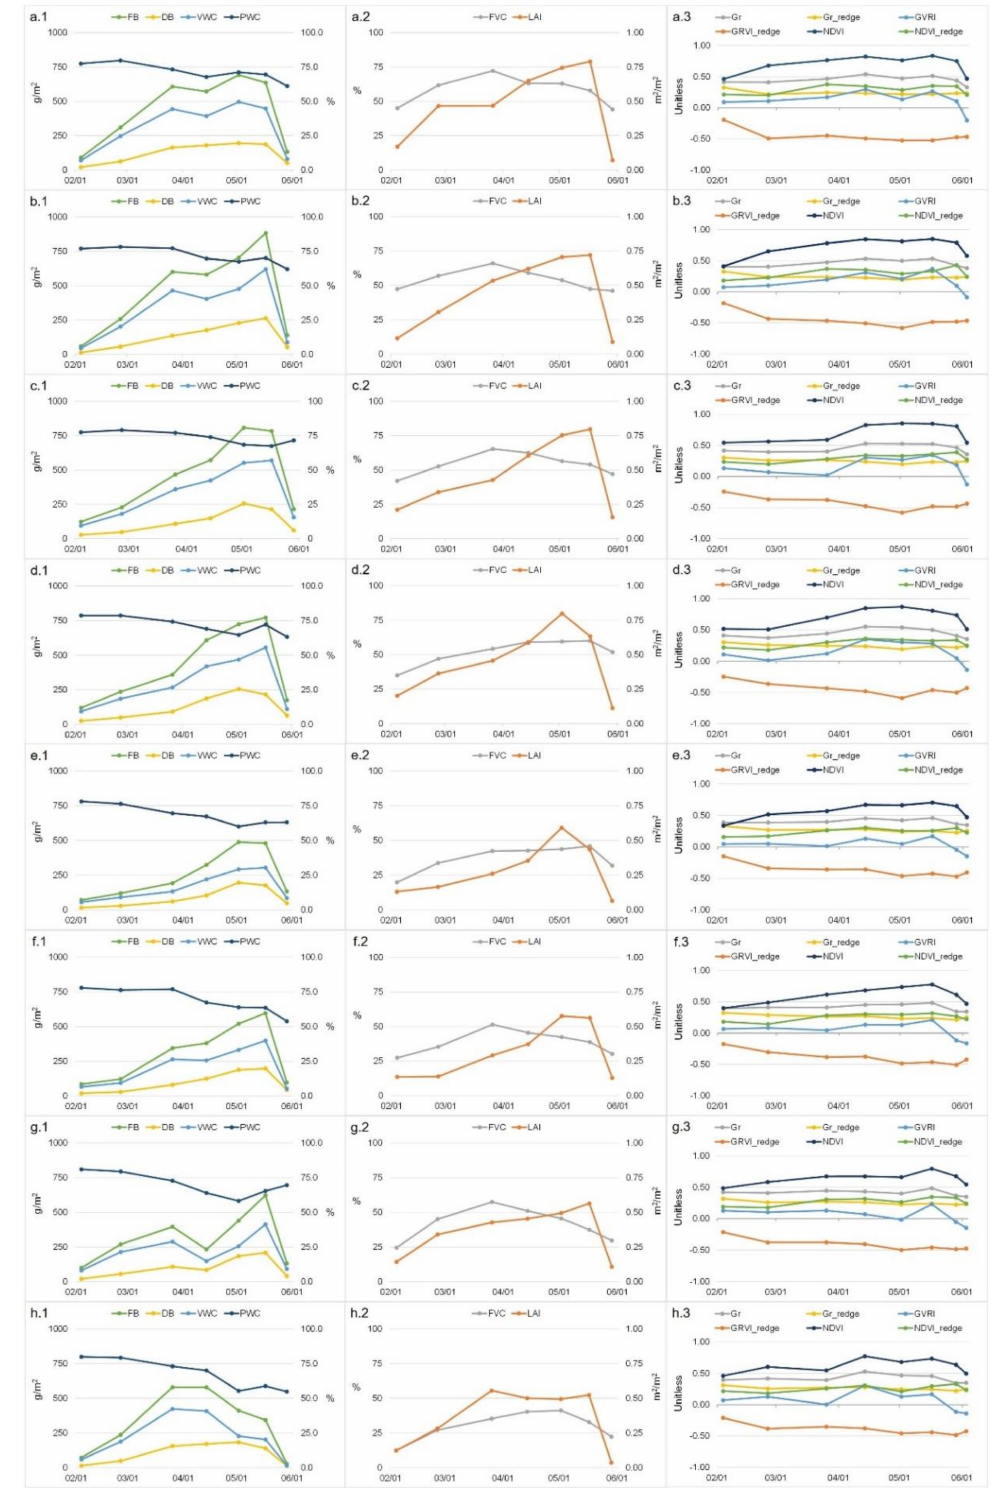
Figure A2. Temporal evolution of field measurements and spectral indices for the eight associations. Letter ( a ) correspond to vetch-barley-triticale (VBT), ( b ) to vetch-triticale (VT), ( c ) to vetch-rye (VR), ( d ) to vetch-oats (VO), ( e ) to pea-barley-triticale (PBT), ( f ) to pea-triticale (PT), ( g ) to pea-rye (PR) and ( h ) to pea-oats (PO). FB: fresh biomass, DB: dry biomass, VWC: vegetation water content, PWC: percentage of water content. Subfigure 1 show, FB, DB, VWC and PWC, Subfigure 2 show FVC and LAI and Subfigure 3 show the vegetation